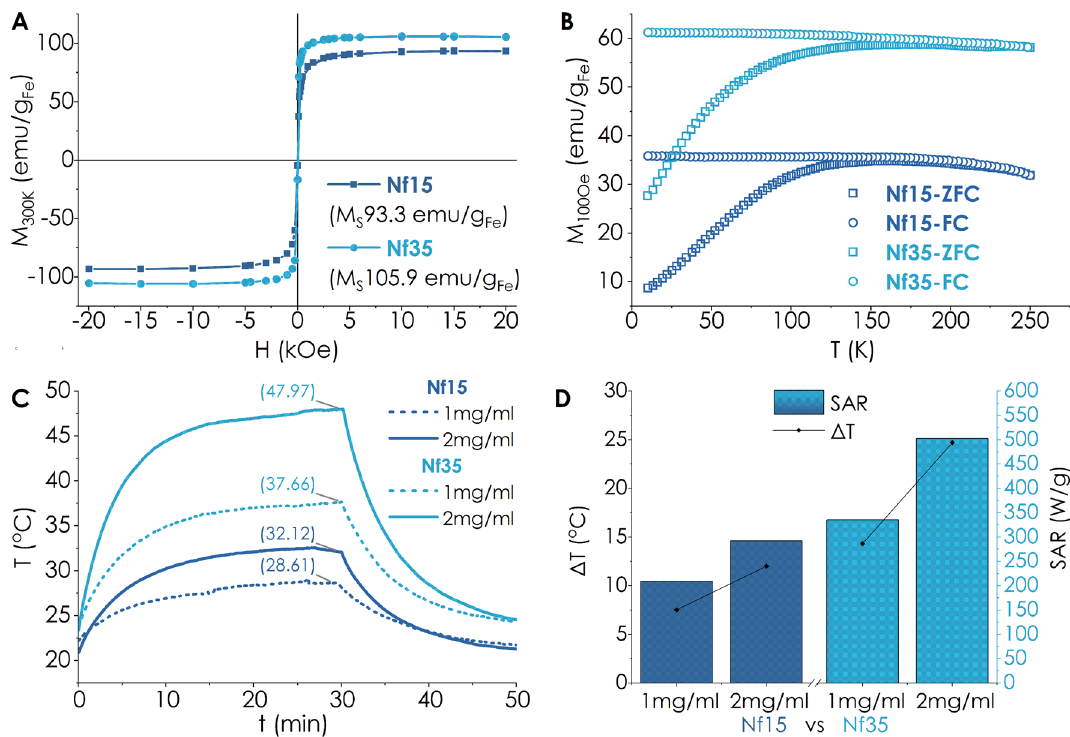
Figure 2. Nf35 shows superior magnetic properties towards magnetic hyperthermia compared with Nf15, as demonstrated by the corresponding ( A ) Hysteresis loop, ( B ) ZFC/FC curves, and their ( C , D ) Magnetothermal